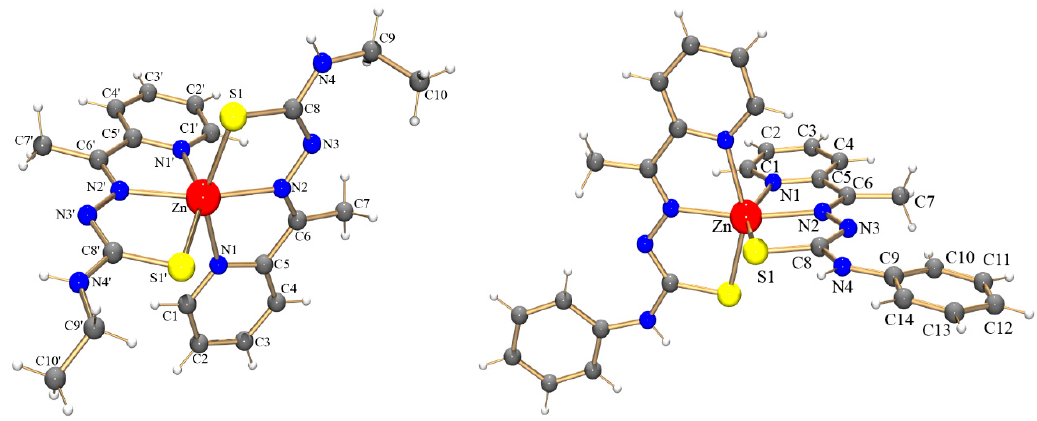
Figure 1. Molecular structure determined for [Zn(atc-Et) 2 ] ( 1 ) ( left ) and [Zn(atc-Ph) 2 ] ( 2 ) ( right ) with atom labels.